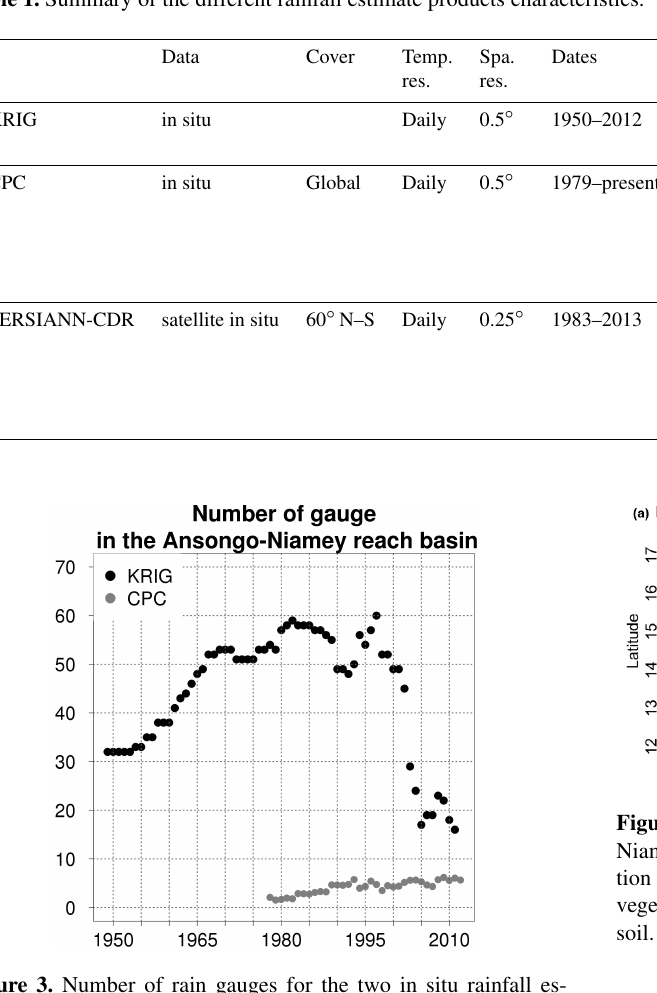
Table 1. Summary of the different rainfall estimate products characteristics.